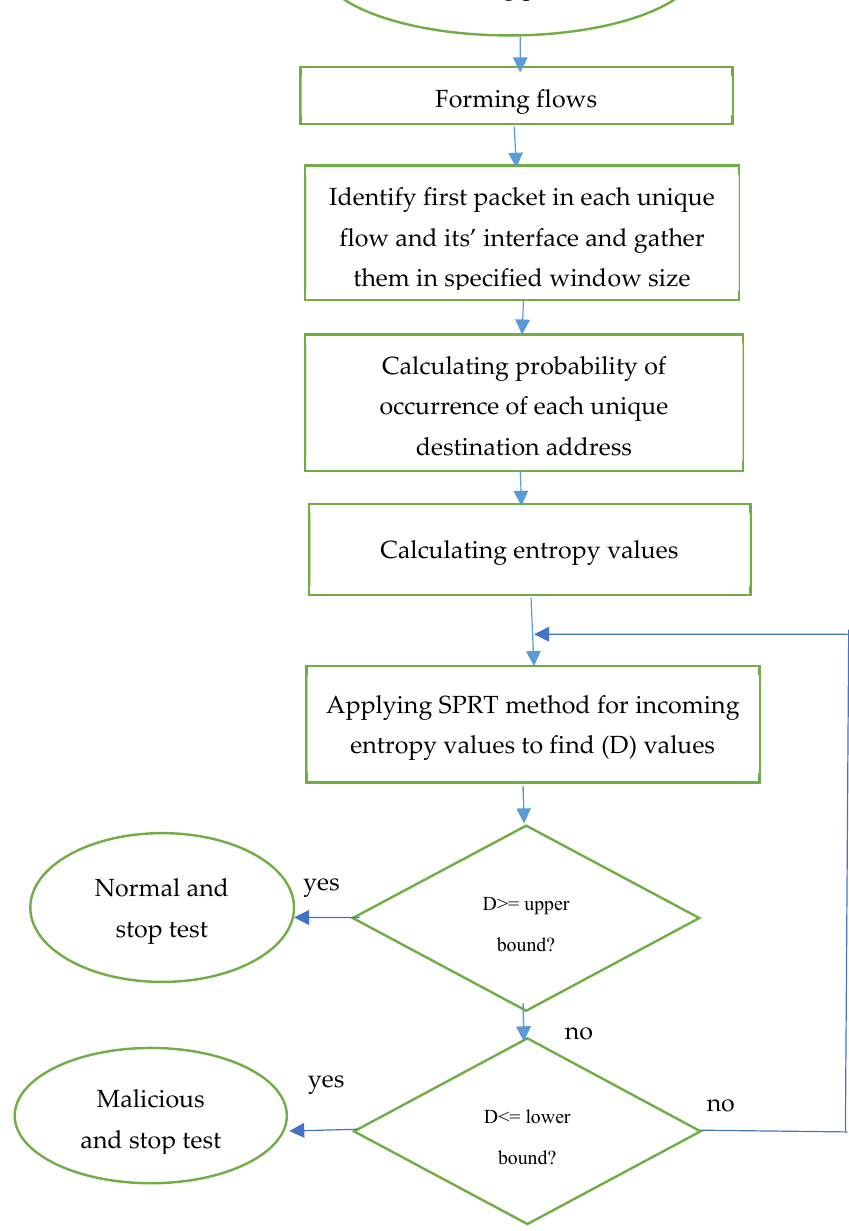
Figure 2. Flowchart for the ESPRT